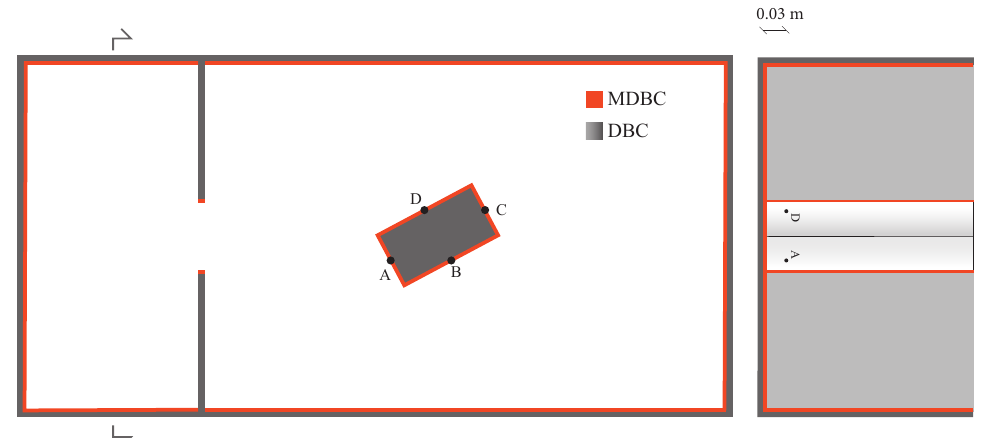
Figure 4. Different treatment of the surfaces: in grey, the ones computed with standard DBC; in orange, the ones with the new mDBC; in black, the reference points for pressure